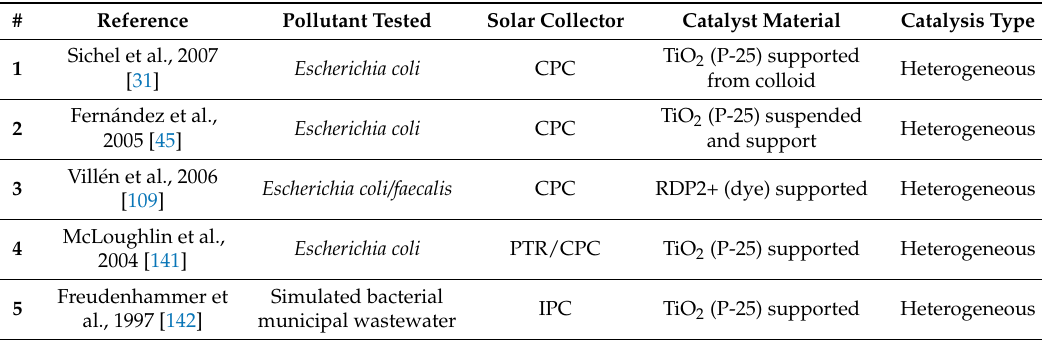
Table 7. SODIS model wastewaters (Bacteria and